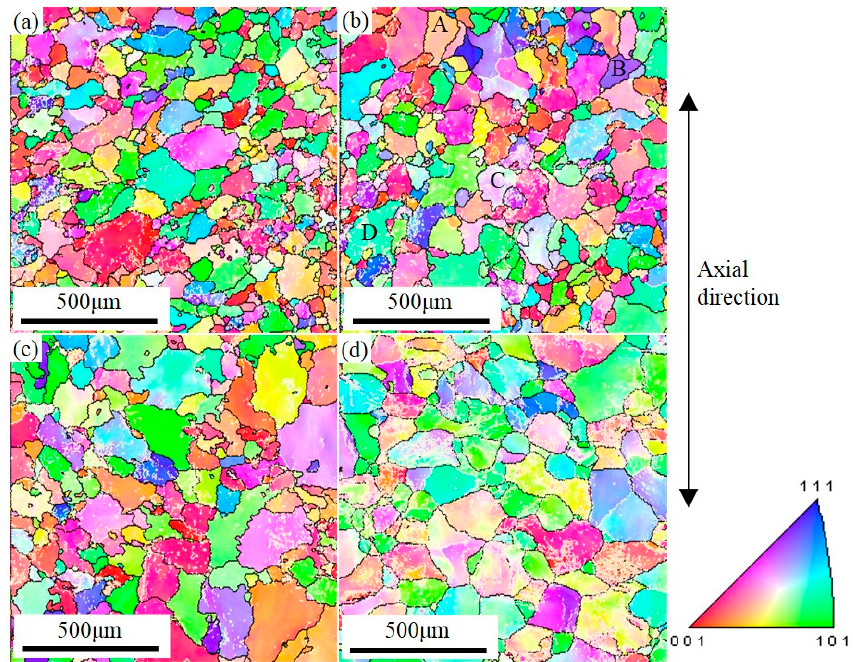
Figure 13. IPF maps of bulged tubes with a mean grain size and strain of ( a ) 80 μ m and 7.52%; ( b ) 105 μ m and 7.15%; ( c ) 130 μ m and 7.03%; ( d ) 175 μ m and 7.22%.